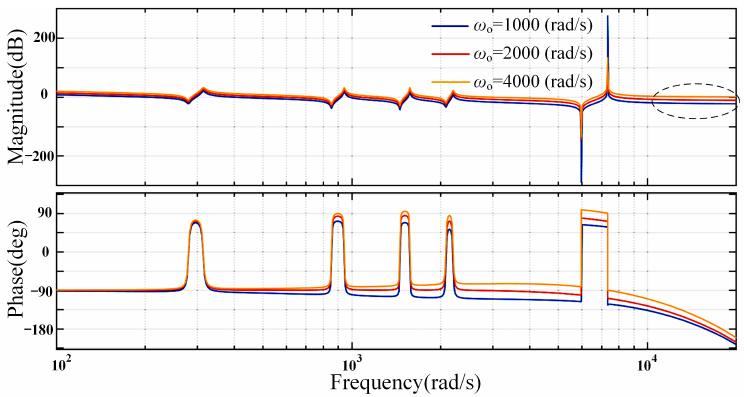
Figure 7. Bode diagram of the system’s open-loop transfer function when ω o